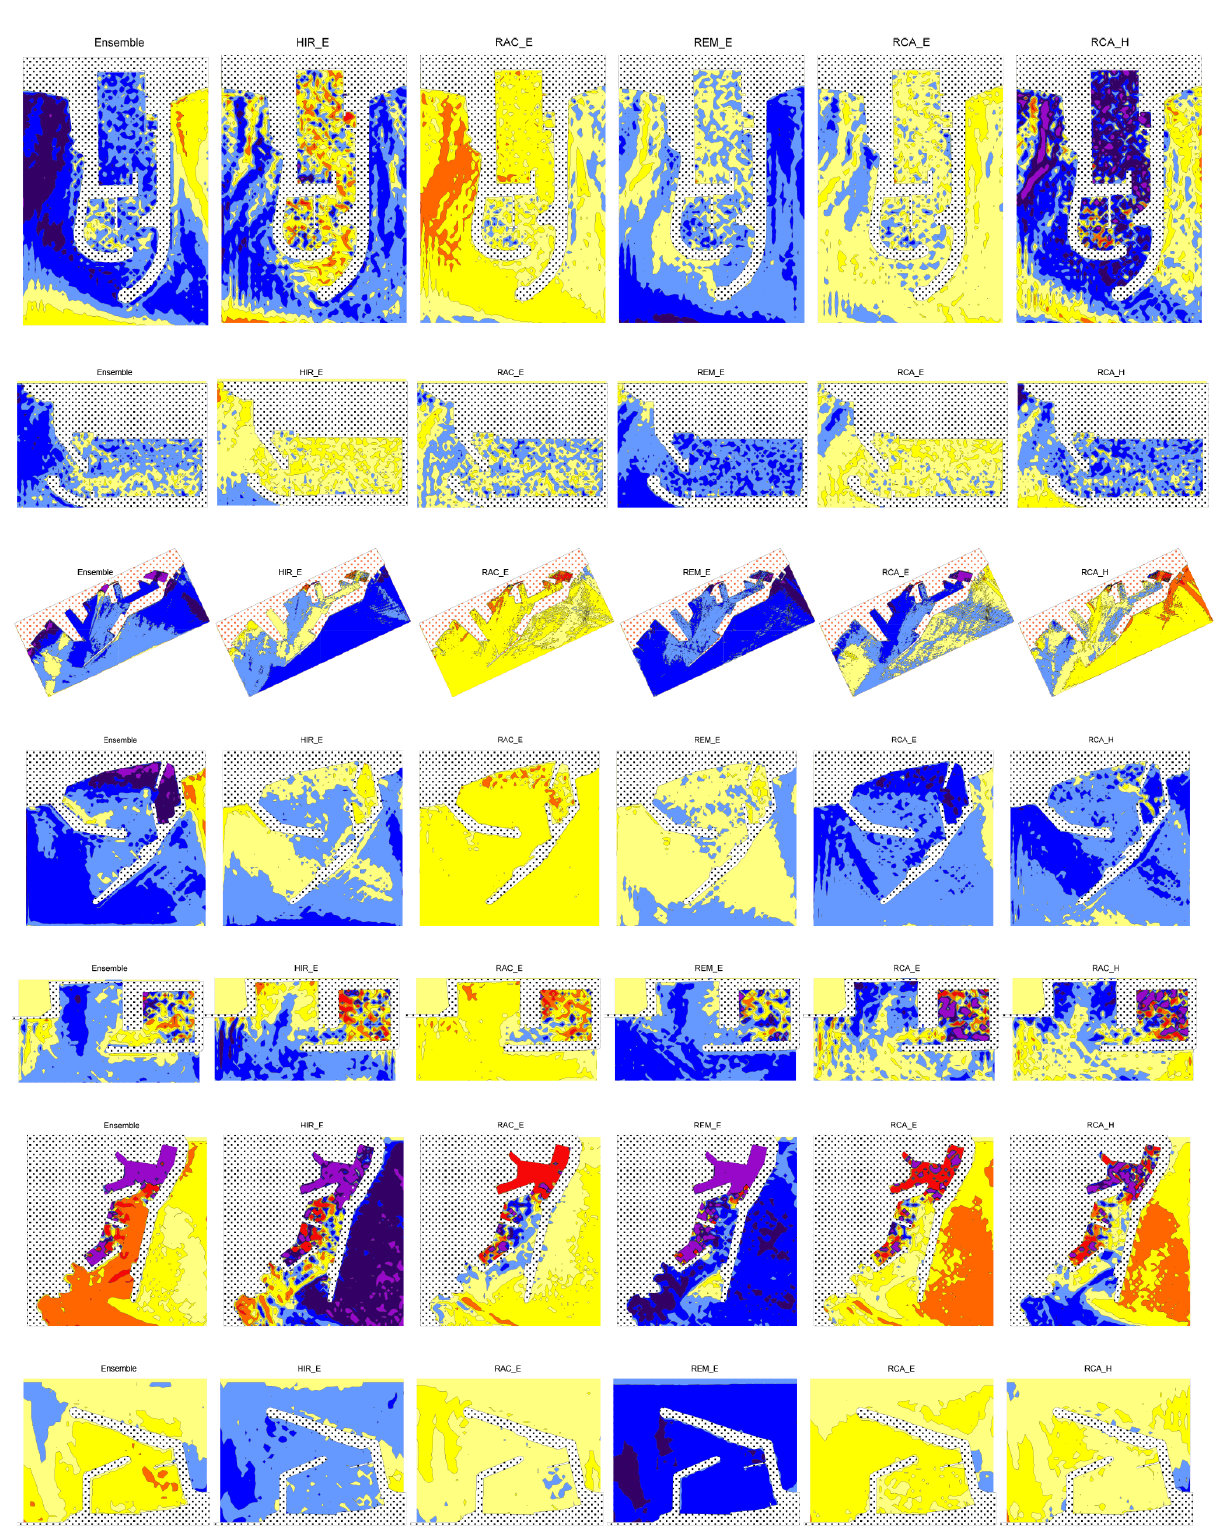
Figure 4. Projected change (future minus present in %) of H s at the studied ports presented as an ensemble of the five models and the anomalies of each model with respect to the ensemble. Panels from left to right: results for the ensemble and anomalies for HIR_E, RAC_E, REM_E, RCA_E and RCA_H models. Panels from top to bottom: Segur de Calafell, Torredembarra, Tarragona, Cambrils, L’Hospitalet de l’Infant, L’Ametlla de Mar and Cases